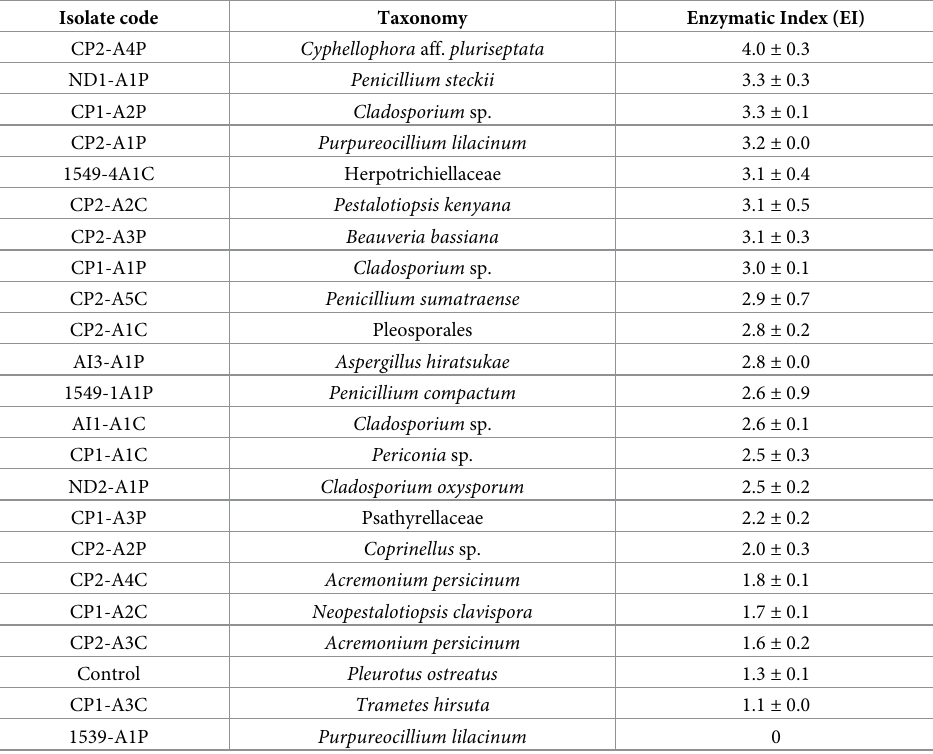
Table 3. Enzymatic index (EI) registered by fungal isolates ( ± indicates standard deviation based on three